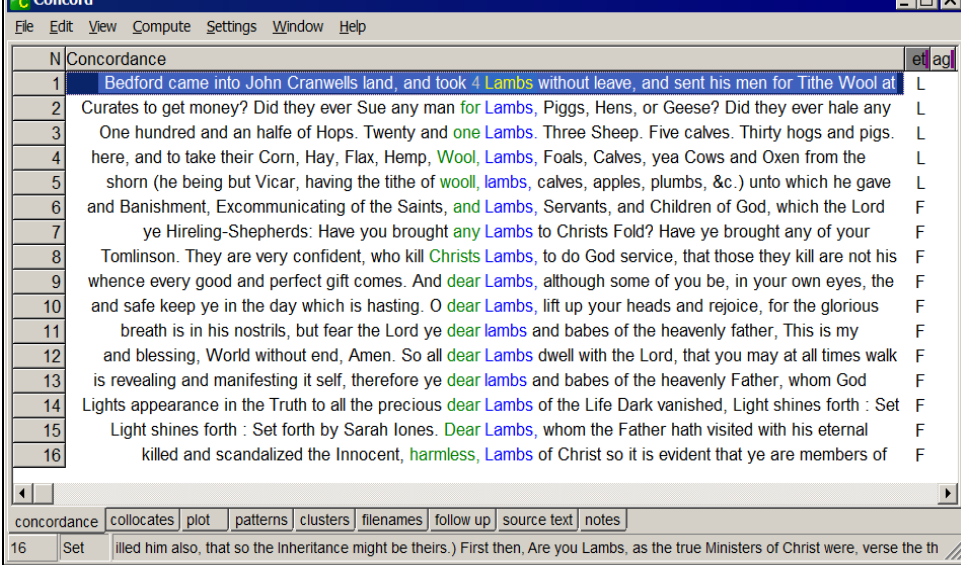
Figure 7. Concordance lines for lambs, and illustrating the use of the ‘SET’ column.